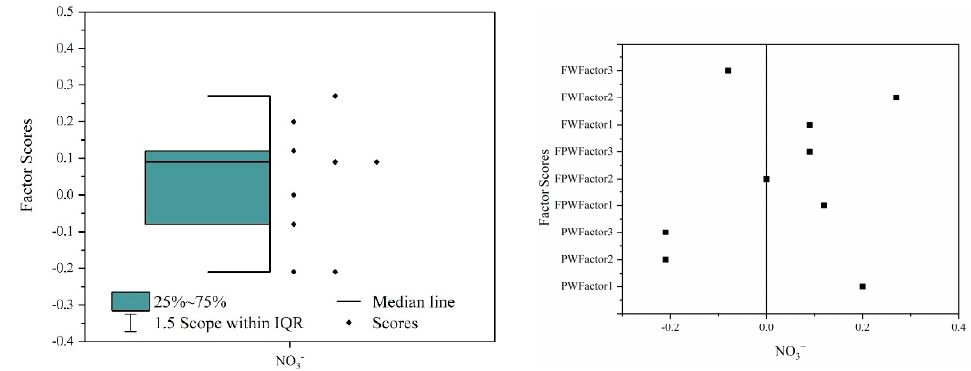
Figure 9. Factor scores of the three groundwater types. (The square indicates that the factor score value is between 25% and 75%).